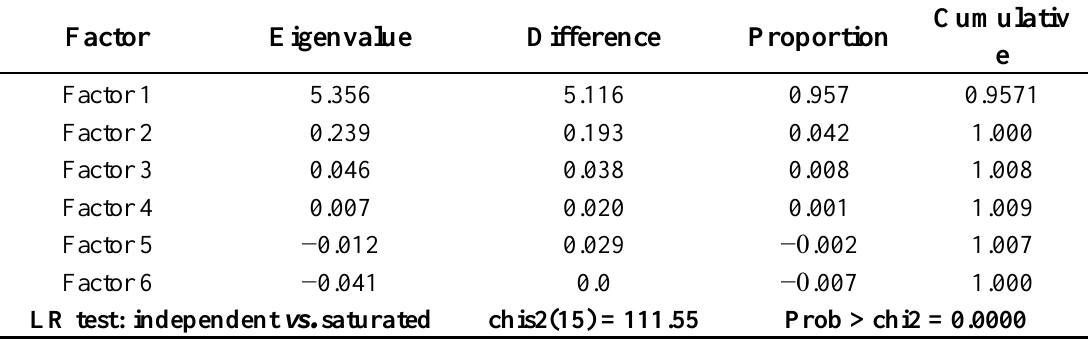
Table 6. Multivariate factor